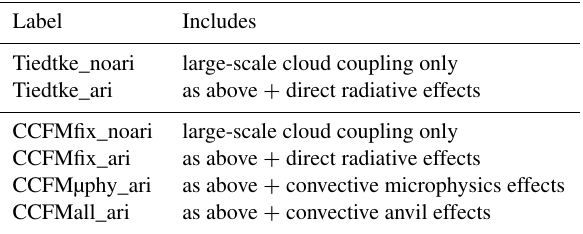
Table 1. Configurations used for aerosol effects in the ECHAM– HAM simulations. “Convective microphysics effects” refers to changes in microphysical process rates (autoconversion, accretion, freezing, etc.) within the convective cloud as aerosol effects on droplet number propagate through the convective microphysics. “Convective anvil effects” refers to changes in the size distribution of droplets and/or ice particles detrained to the large-scale cloud scheme. (See Sect. 2.3 for further details.)